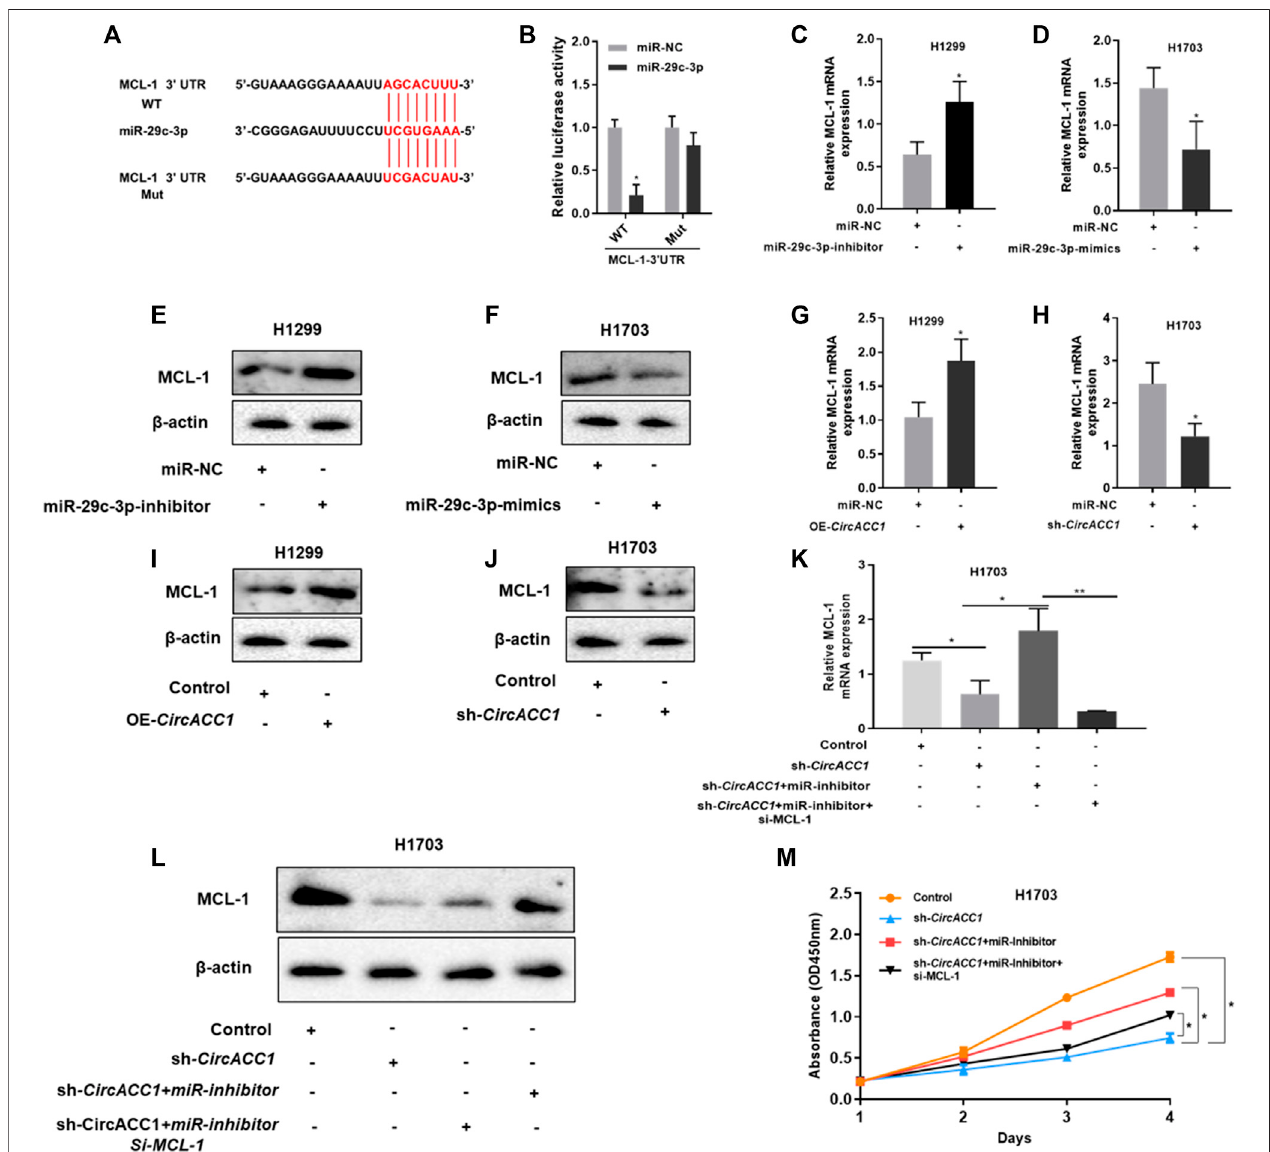
FIGURE4| MCL-1isadownstreamtargetofmiR-29c-3pinNSCLCcells. (A,B) .TheluciferaseactivityofLuc-MCL-1-wtorLuc-MCL-1-mutantinNSCLCcellsco- transfected with miR-29c-3p mimics. Data are mean ± SD. * p < 0.05; (C,D) . mRNA expression of MCL-1 in H1299 and H1703 cells co-transfected with miR-29c-3p inhibitorormimic,respectively,byRT-qPCR.Dataaremean ± SD,* p < 0.05; (E,F) .ProteinexpressionofMCL-1inH1299andH1703cellsco-transfectedwithmiR-29c- 3pinhibitorormimic,respectively,byWesternblot; (G,H) .mRNAexpressionofMCL-1inLV-H1299-circACC1andLV-H1703-shcircACC1celllinesbyRT-qPCR. Dataaremean ± SD,* p < 0.05; (I,J) .Proteinexpression ofMCL-1inLV-H1299-circACC1andLV-H1703-shcircACC1 celllinesbyWestern blot; (K) .mRNAexpression ofMCL-1ingivencelllinesbyRT-qPCR.Dataaremean ± SD,* p < 0.05,** p < 0.01; (L) .ProteinexpressionofMCL-1ingivencelllinesbyWesternblot; (M) .CCK-8assay of the given cell lines. Data are mean ± SD, * p <